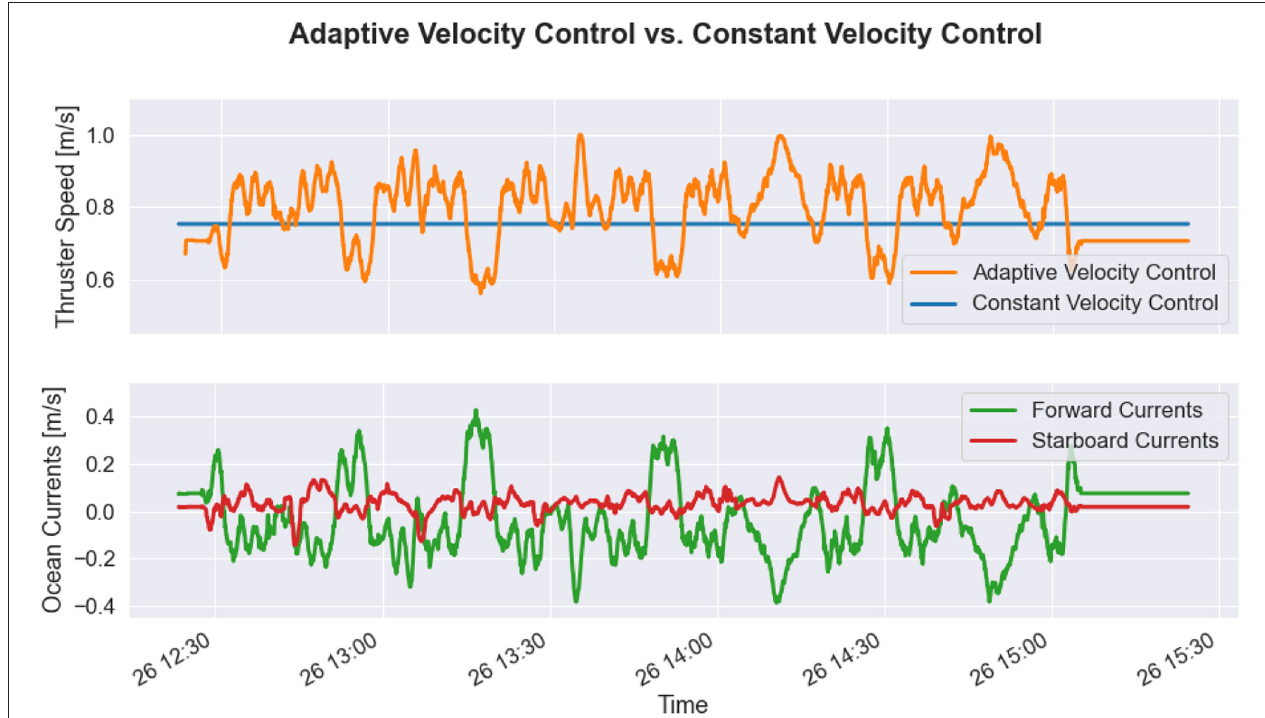
FIGURE 11 | Adaptive velocity control (AVC) when applied to Dive A of the November 2019 deployment in the southern Aegean Sea. The hybrid adaptive speed curve (orange) shows the optimal glider speed over time, which responds to varying ocean current conditions. The hybrid constant speed (blue) is only optimized with respect to hotel load, so it does not change during the mission. The forward currents (green) and starboard currents (red) during mission are estimated via the velocity shear propagation (VSP) method. In periods of strong favorable currents, the glider slows down, while in periods of strong adverse currents, the glider speeds up, thus adaptively taking advantage of environmental